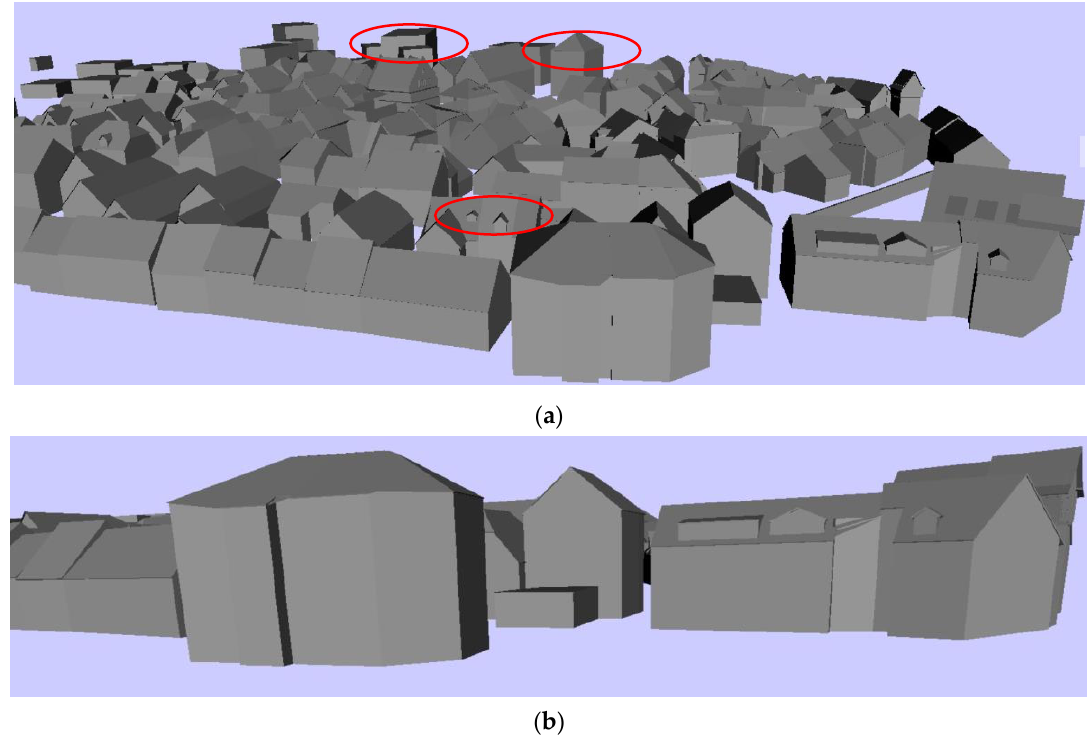
Figure 15. Progressive visualization of BuildingTree. ( a ) Fly view. ( b ) Street level view